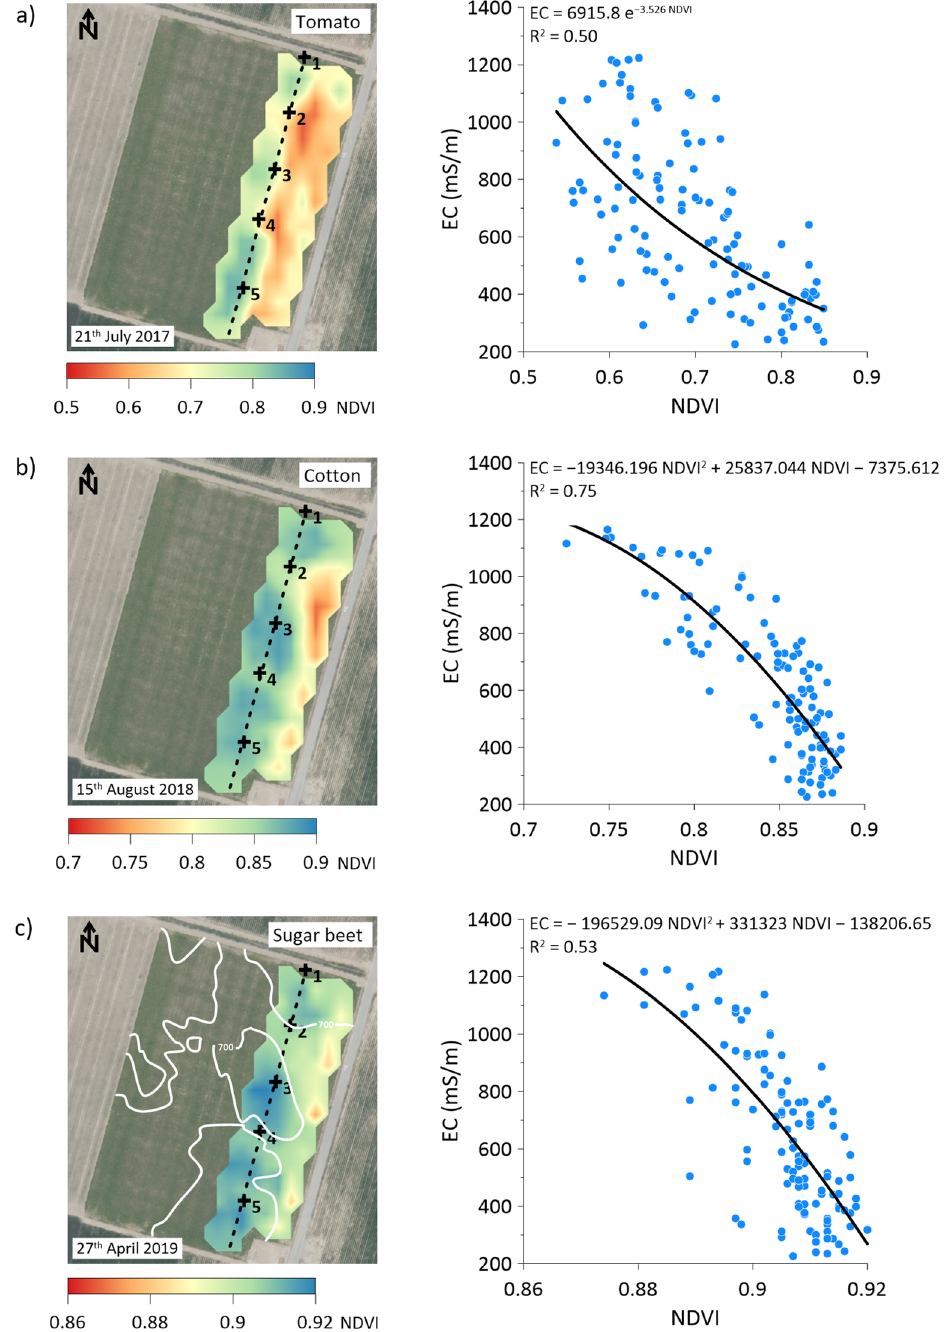
Figure 11. NDVI patterns and NDVI–EC relationships with depth-specific EC at 0.9 m measured in 2017 on the day of maximum NDVI for ( a ) processing tomato; ( b ) cotton; and ( c ) sugar beet. The white line represents EC= 700 mS m − 1 at 0.9 m depth.